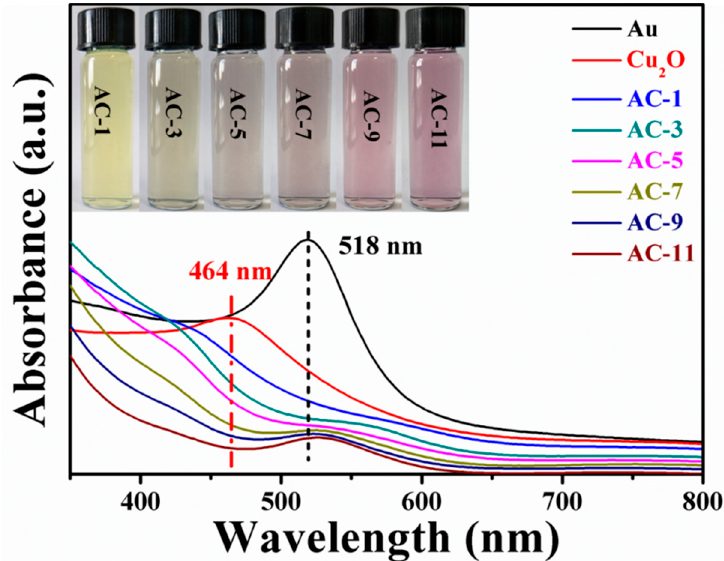
Figure 4. UV–Vis absorption spectra of Au colloid solution, Cu 2 O nanocrystals, AC-1 NCs, AC-3 NCs, AC-5 NCs, AC-7 NCs, AC-9 NCs, and AC-11 NCs. The inset is the photograph of AC-1 NCs,